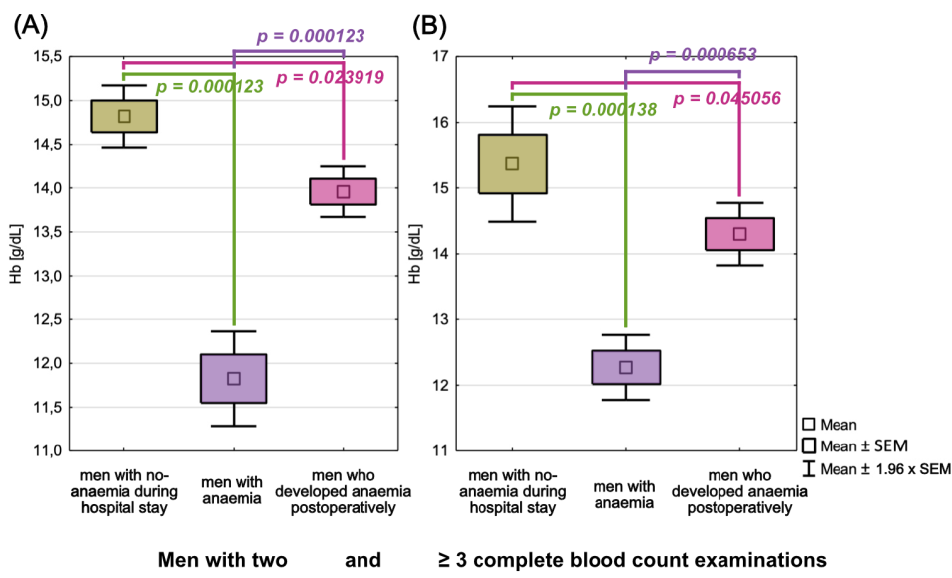
Figure 5. Differences in haemoglobin concentrations in the first complete blood count examination between men with and without anaemia, as well as men who developed anaemia post-operatively, who had two ( A ) and ≥ 3 complete blood count examinations ( B ).